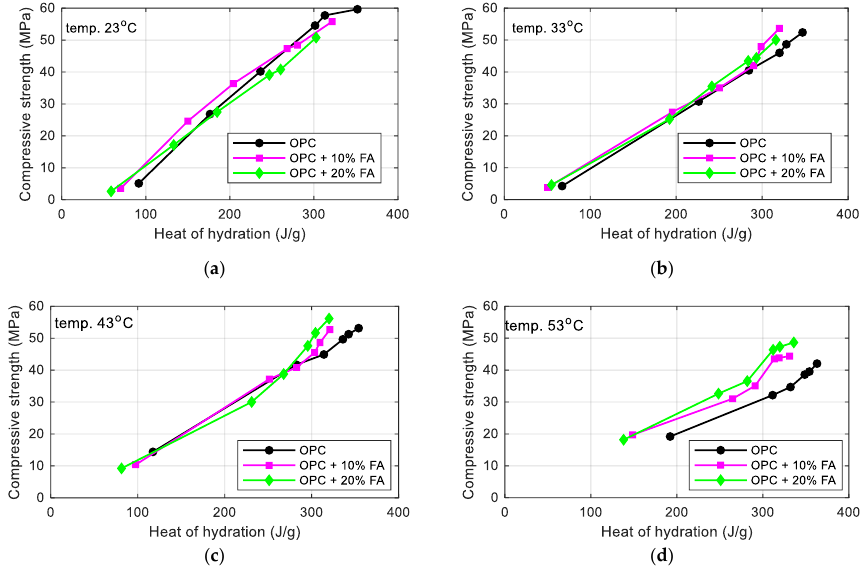
Figure 5. Compressive strength vs. heat of hydration released at temperatures: ( a ) 23 °C; ( b ) 33 °C; ( c ) 43 °C; ( d ) 53 °C.